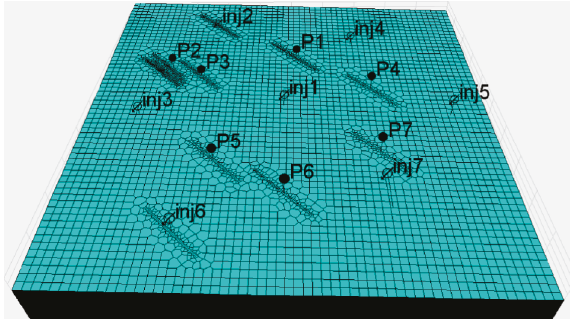
Figure 3: Three-dimensional numerical model of unstructured